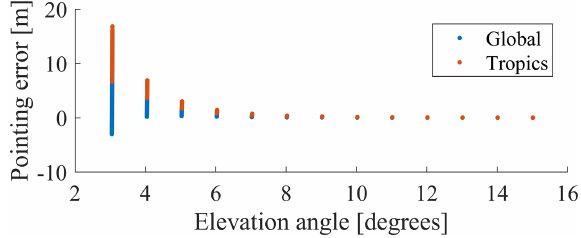
Figure 4. Point error at the voxel model top ( h = 13 . 6km) caused by the bending model of Hobiger et al. (2008) – computed on a global 10 ◦ × 10 ◦ grid over the period of one year, 2014, by com- parison with ray-traced bending angles based on ECMWF analysis data.